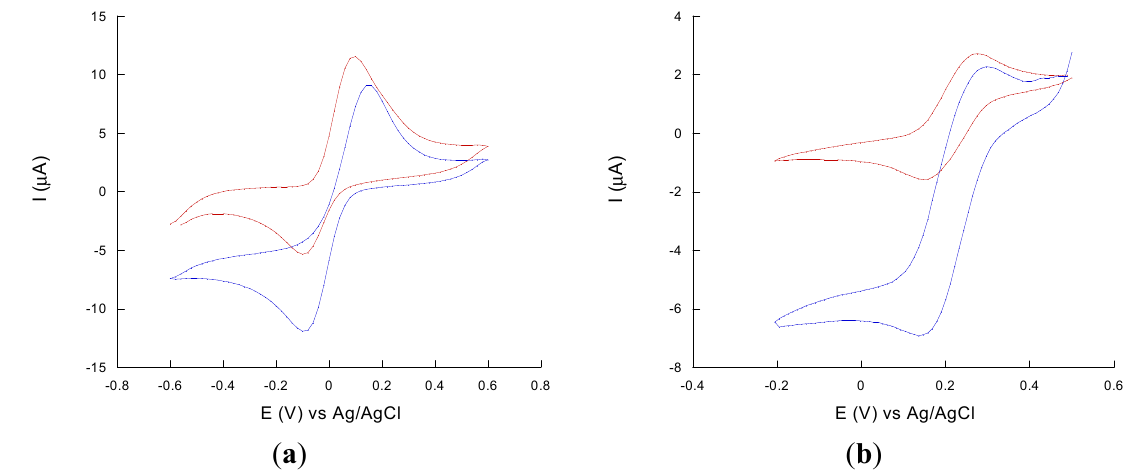
Figure 3. Cyclic voltammograms for 0.5 mM ( a ) 2,2 ′ -Azino-bis(3-ethylbenzothiazoline-6- sulfonic-acid diammonium salt (ABTS) or ( b ) caffeic acid solution onto a MWCNTs- poly(vinylalcohol) (PVA)-AuNPs before (red curve) and after (blue curve) the immobilization of